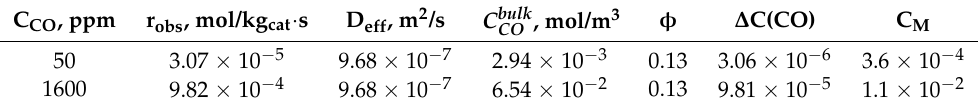
Table A3. Calculated parameters for internal and external diffusion and heat transfer at 25 ◦